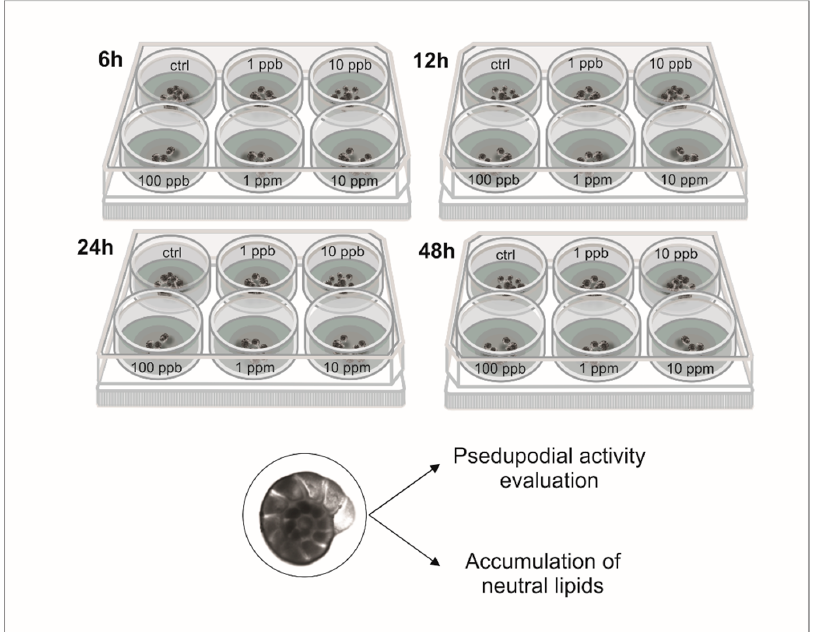
Figure 1. Schematic design of the experiment. The multiwell culture plate denotes the time (6 h, 12 h, 24 h and 48 h), whereas the wells represent the Cd concentrations (control, 1 ppb, 10 ppb, 100 ppb, 1 ppm and 10 ppm). Living specimens of A . cf. parkinsoniana were placed in each well and analyzed at a pre-established time interval for pseudopodial activity and lipid content.